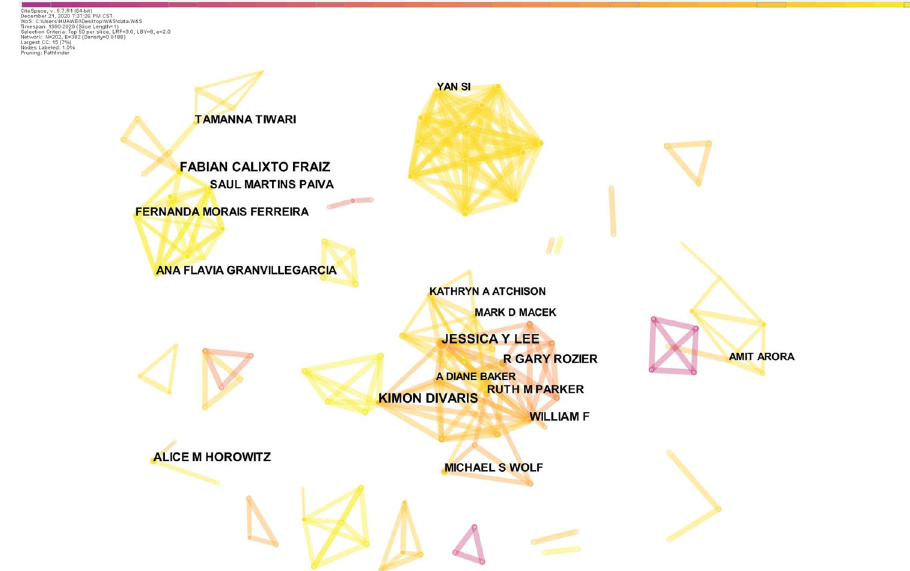
Fig. 3 The distribution of authors. The network map of active authors offered to oral health literacy Table 2. Top 10 authors according to the number of publications. Ranking